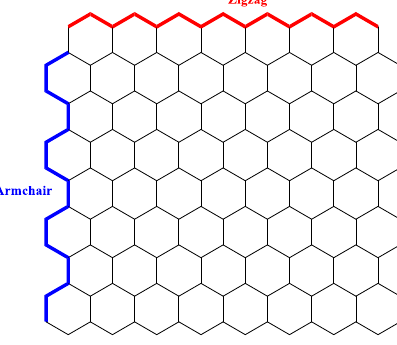
Figure 3. Zigzag–edged and armchair–edged of graphene (GNs). Nanomaterials 2020 , 10 , x FOR PEER REVIEW